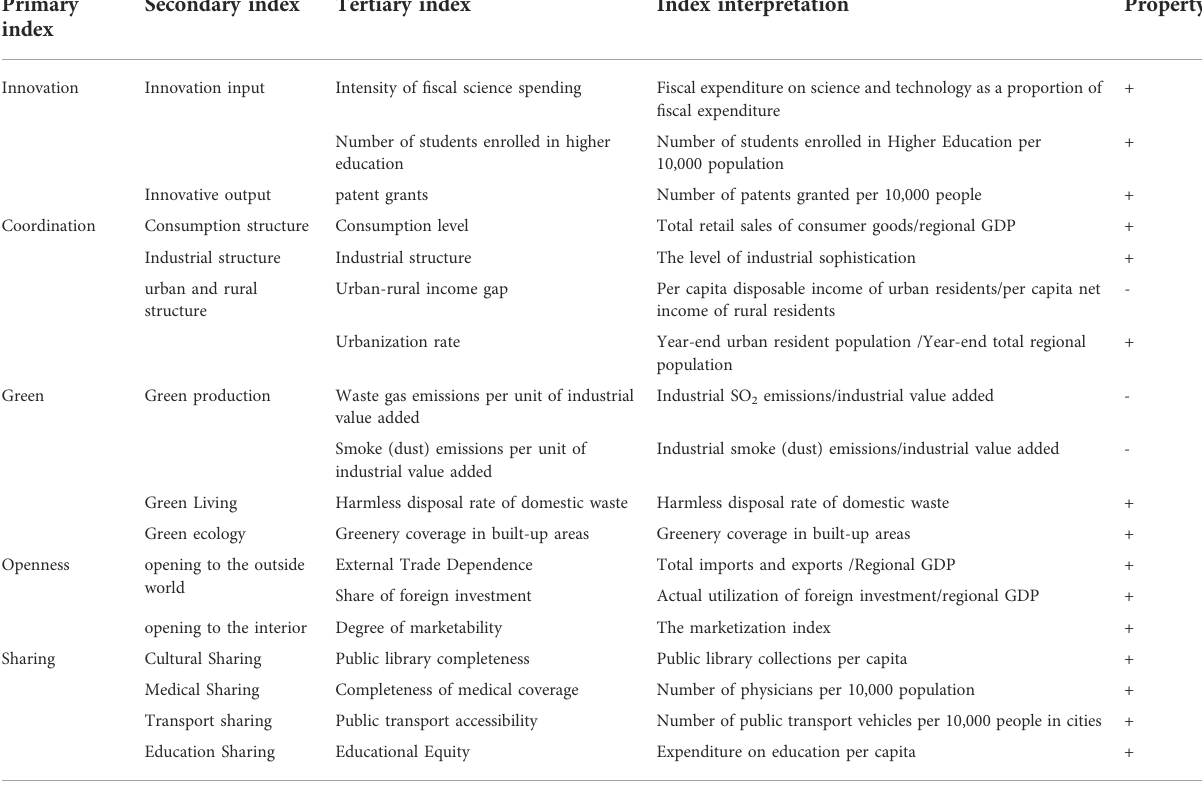
TABLE2Evaluationindexsystem forhigh-qualityeconomic developmentofthethreemajorcityagglomerations